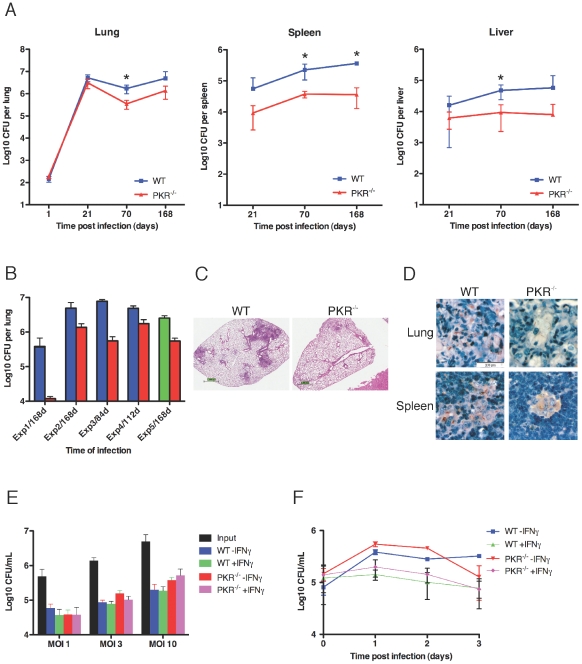
Course of Mtb infection in PKR-deficient and wild type mice.(A) Time course of burden of colony-forming units (CFU) in lung, liver and spleen over 24 weeks following infection by inhalation of an average of 30 CFU by wild type mice and 37 CFU by PKR-deficient mice. Results are means ± SD for 5 mice per time point. Asterisks mark time points at which the differences had p values≤0.01 by Student's t test. (B) Mtb burdens (mean CFU ± SEM for 4–6 mice per strain) in lungs of mice from 5 independent experiments at the latest time point post-infection evaluated in each experiment. Red bars: PKR−/− mice. Blue bars: C57LB/6 wild type controls. Green bar: 129S1/SvImJ wild type controls. The initial bacterial burdens were comparable between mouse strains within each experiment as assessed by the following CFU counts 24 hours post infection (pairs are means for wild type mice followed by PKR-deficient mice in individual experiments in the order depicted in the figure): 30, 37; 15, 20; 24, 22; 488, 468; 40, 45. The unusually low CFU seen in the first experiment are depicted with reference to an expanded Y-axis. (C and D) Histopathology (C) and acid-fast staining of Mtb (D) in lungs from Mtb-infected wild type and PKR−/− mice at day 168 from a representative experiment. (E and F) Comparable uptake and control of Mtb by PKR-deficient and wild type macrophages in vitro. (E) Uptake of Mtb 4 hours after addition at the indicated MOI, with and without exposure of macrophages to IFN-gamma (10 ng/mL) overnight in advance of infection. (F) Intracellular growth of Mtb (MOI = 3) with and without exposure of macrophages to IFN-gamma (10 ng/mL) overnight in advance of infection. With the other MOIs tested (1 and 10), there was likewise no significant difference in the numbers of CFU in PKR-deficient and wild type macrophages over the 3 days studied.